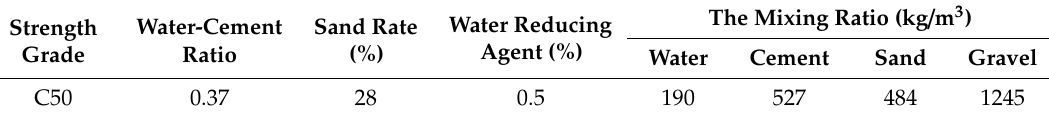
Table 3. Concrete mix